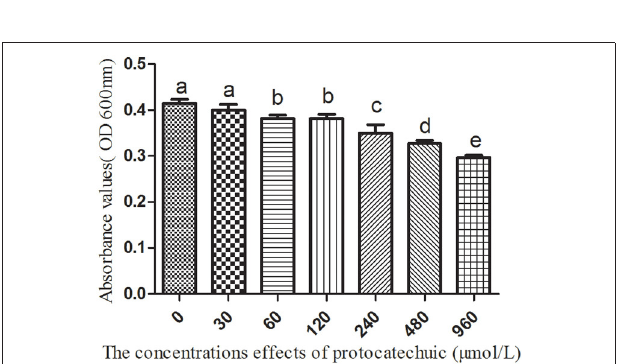
FIGURE 9 | The effects of protocatechuic acid on the growth of Bacillus pumilus Z. Columns with different letters are statistically different (LSD-test, p < 0.05